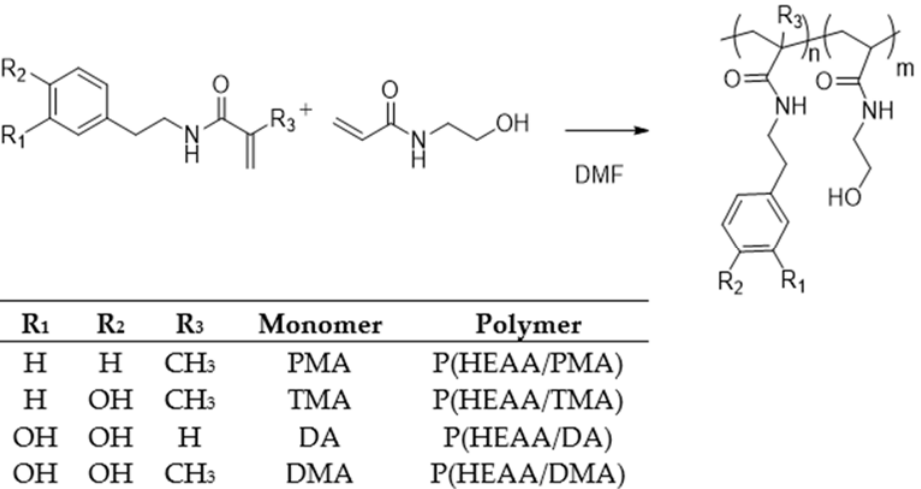
Figure 2. AIBN initiated polymerization with dopamine-modified acrylamides and HEAA to copoly- mers.